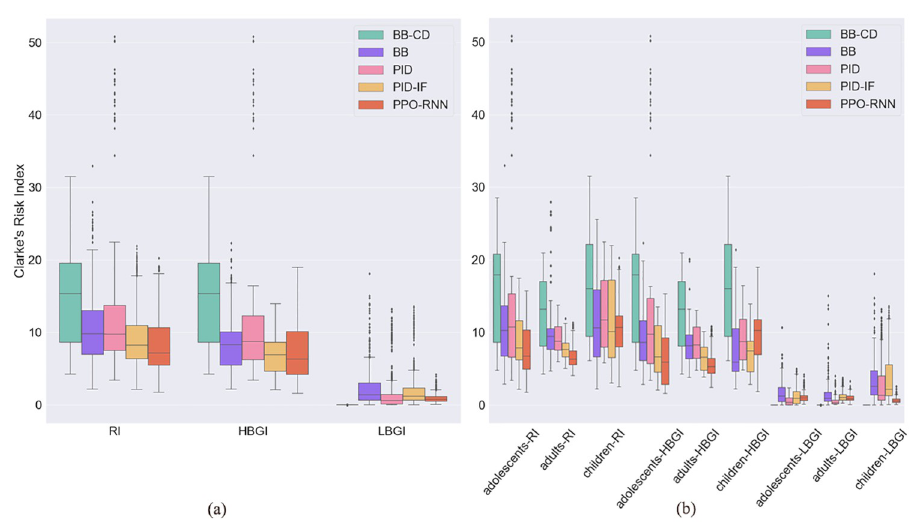
Fig 5. Comparative fraction of risk indexes. (a) Global risk index (b) Risk index by group.